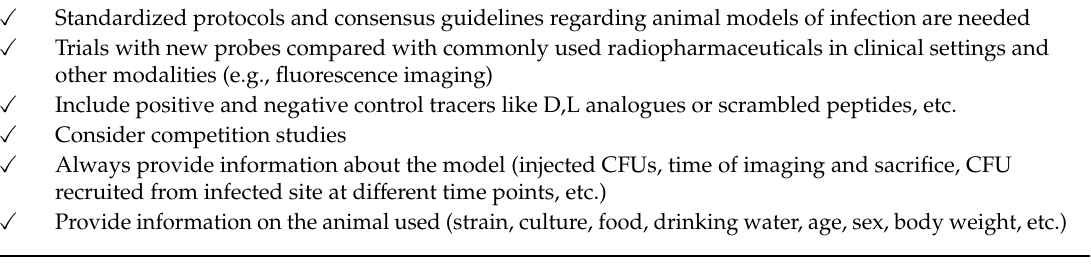
Optimize Animal Models (Figure 2)